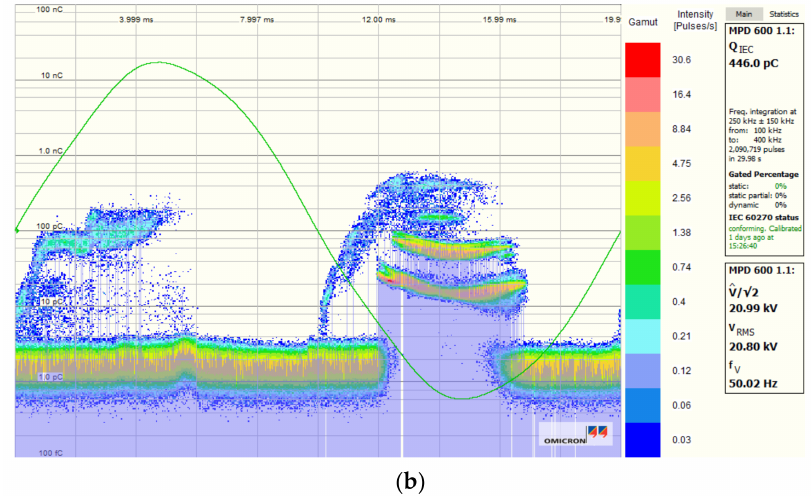
Figure 13. PD measurement results of sample B: ( a ) before and ( b ) after the 29th aging.